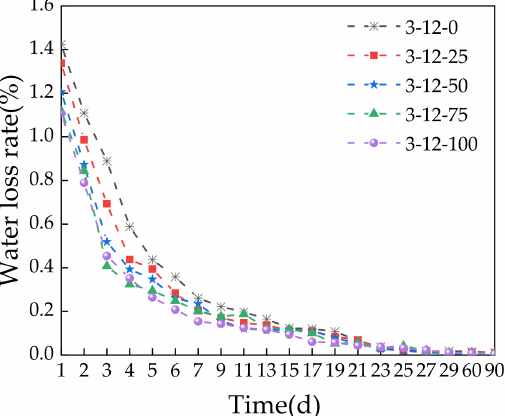
Figure 13. Relationship between the storage time and water loss